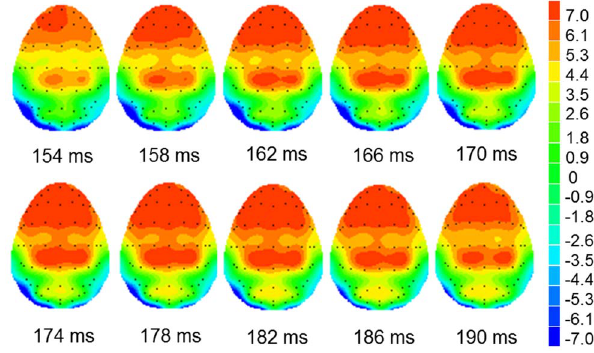
Figure 3. Topography of fearful faces at time window of 154– 190 ms. Scalp potential maps reveal the topography of the interference effects of fearful faces on the Chinese word judgment tasks in the time window of 154–190